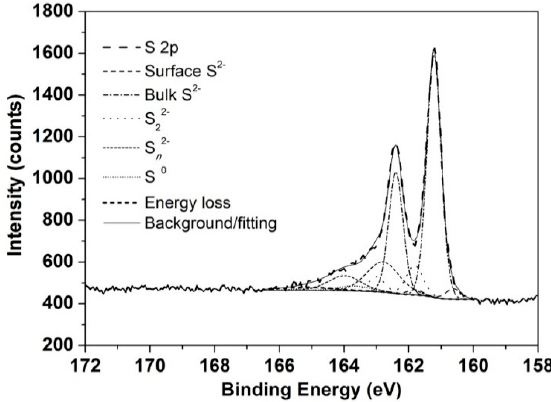
Figure 6. High-resolution S 2 p XP spectra collected from chalcopyrite leached for 1 h at 750 mV, 75 °C and pH 1.0 without iron addition. Table 4. S species (% S) for feed chalcopyrite and chalcopyrite surfaces leached at 750 mV, 75 °C and pH 1.0 for 1 h and 30 h.